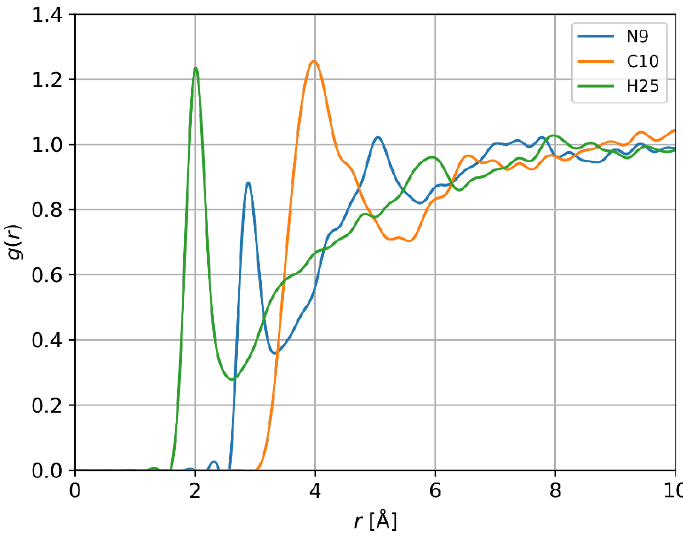
Figure 8. Representative RDFs of the HBMF molecule.